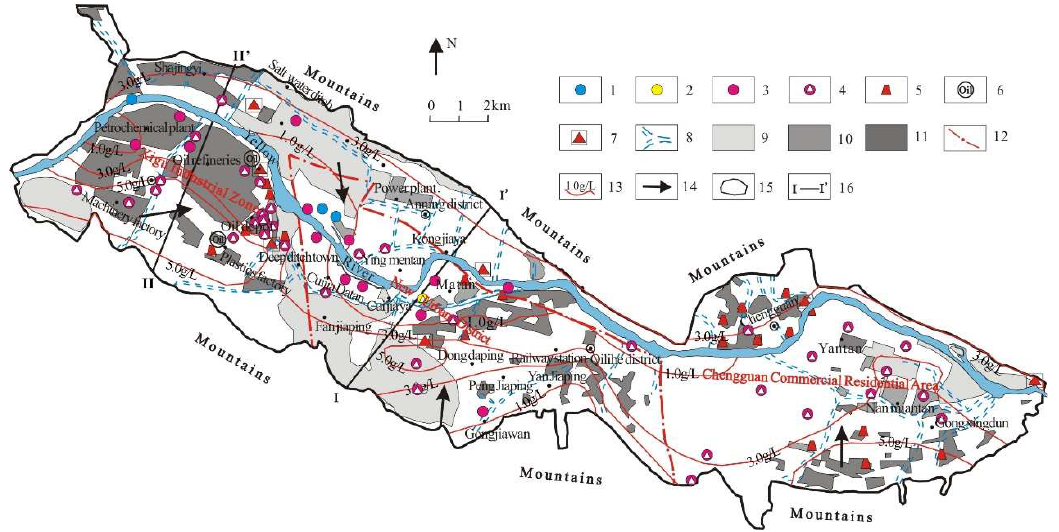
Figure 8. Evaluation of groundwater quality and identification of hydrochemical abnormal